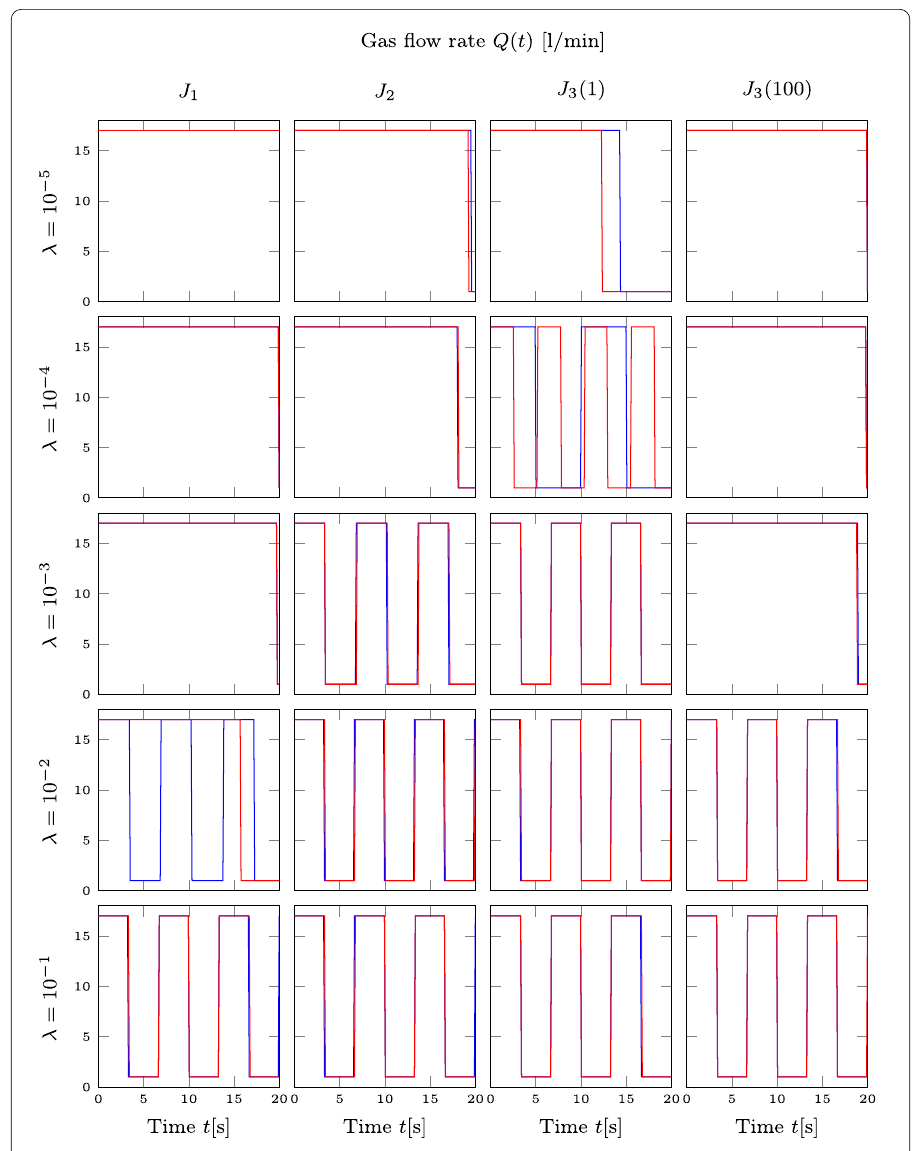
Figure 6 Optimization of gas flow rates. Optimal gas flow rates for level 3, (cid:18) t = 0.025, different objective functionals, and different parameters λ . The frequencies correspond to the values given in Table 5: blue: nozzle 1; red: nozzle